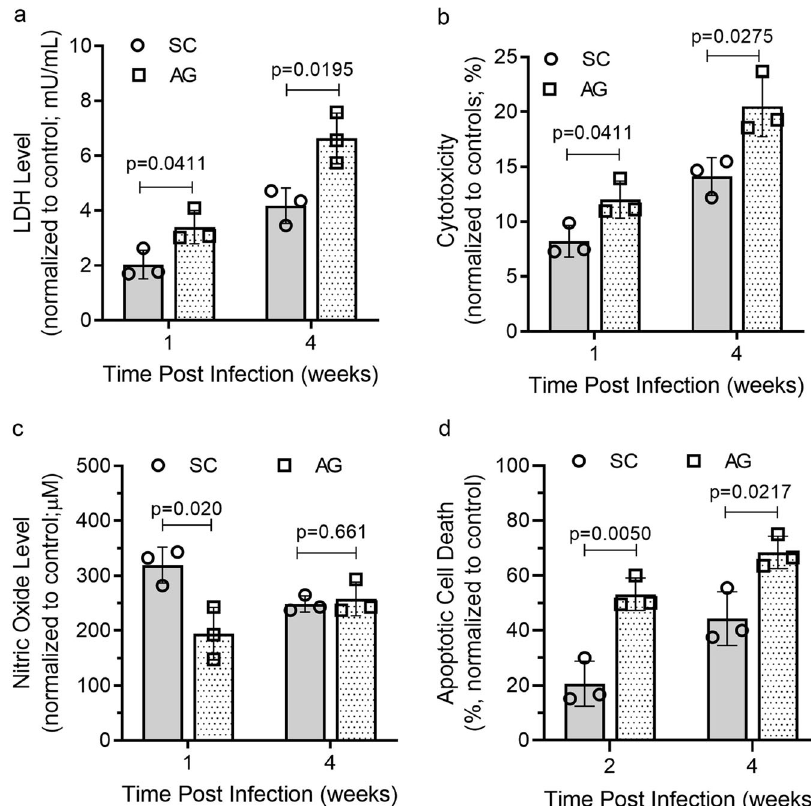
Fig. 6 Mtb-AG exacerbates LDH levels, cytotoxicity, apoptosis, and dampens NO 2 levels in the infected rabbit lungs. a LDH levels were measured colorimetrically in the lung homogenates and b cytotoxicity was calculated from the LDH levels. c Nitric oxide level was determined by the Griess method using fi ltered cell lysate from infected rabbit lungs. d Apoptotic cell death was calculated by TUNEL assay on rabbit lung sections at 2 and 4 weeks post infection. All parameters were compared against uninfected control animals at 1 or 2 and 4 weeks post infection. n = 3 rabbits per group. Data were analyzed by Mann – Whitney U Test.